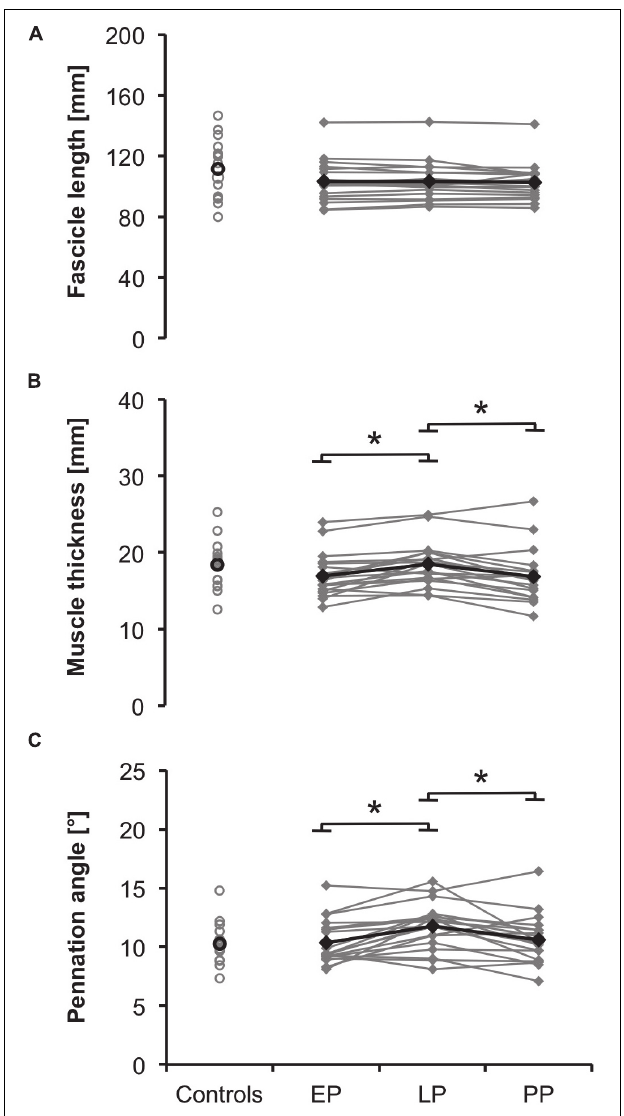
FIGURE 2 | Means (black) and individual data (gray) for the architectural parameters fascicle length (A) , muscle thickness (B) , and pennation angle (C) for the non-pregnant controls and the pregnant women at the early (EP) and late (LP) stage of pregnancy as well as postpartum (PP) ( ∗ p < 0.05).